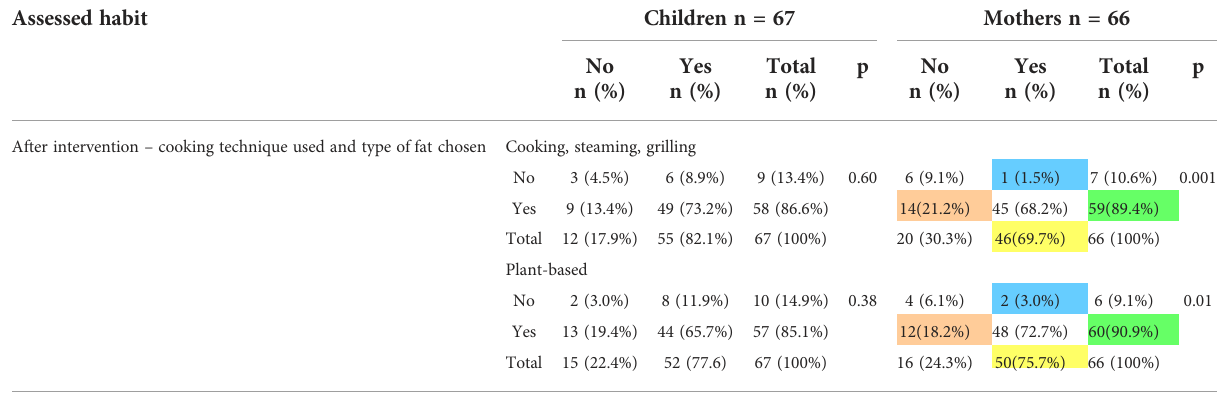
TABLE 8 Effect of one-year dietary intervention on cooking techniques and type of cooking fats used by studied children and their mothers. . Assessed